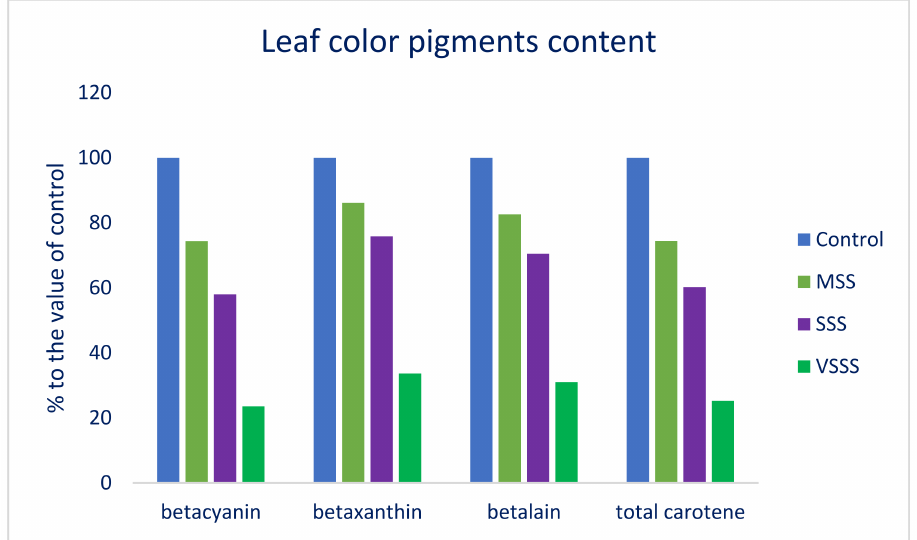
Figure 3. Response of leaf color pigment content (% to the value of control) under four salinity levels: Control (no saline water); MSS = medium salinity stress (50 mM NaCl); SSS = severe